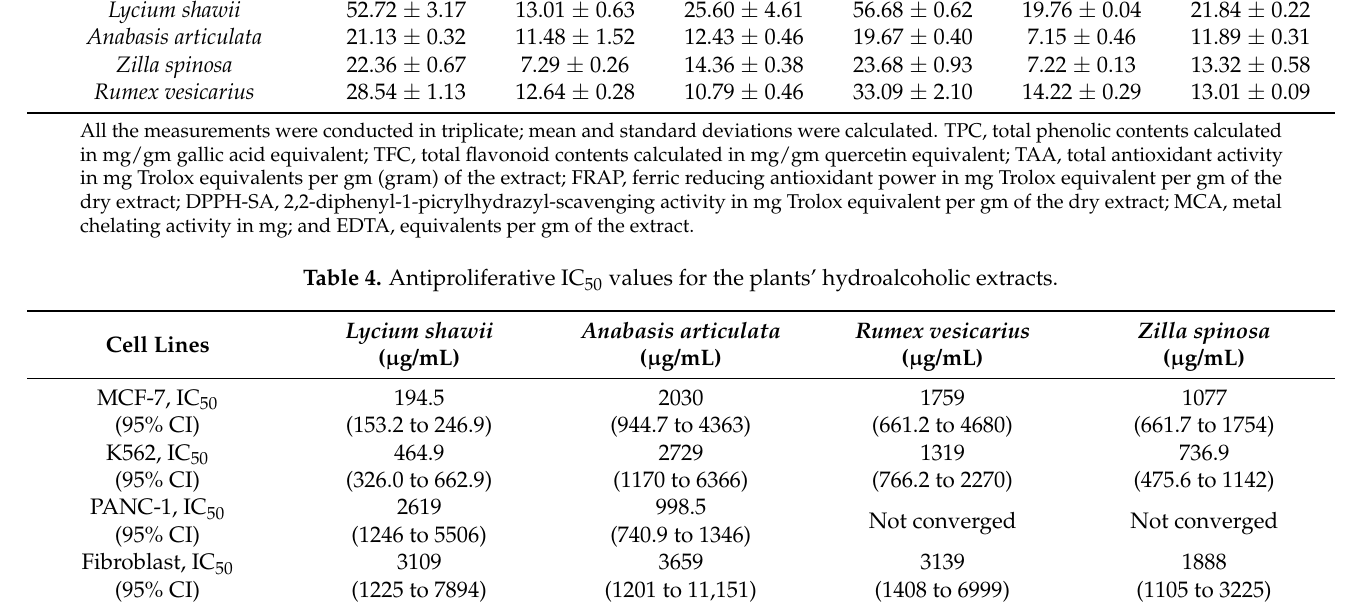
Table 3. Quantitative analysis of the total phenolics, flavonoids, and antioxidant activity in mg/gm of the dried plants’ extracts. Quantitative Tests Plants